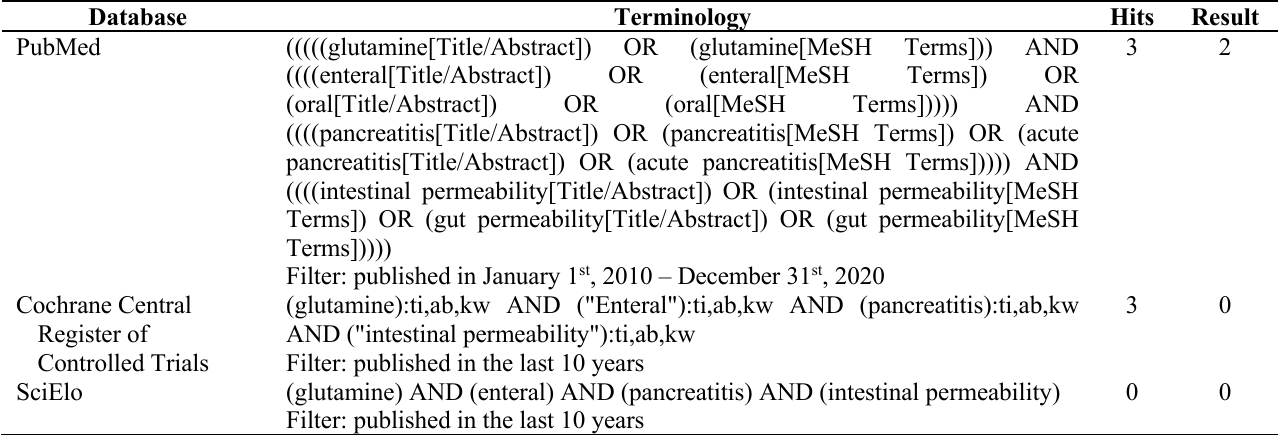
Table 1 . Terminology used in three databases